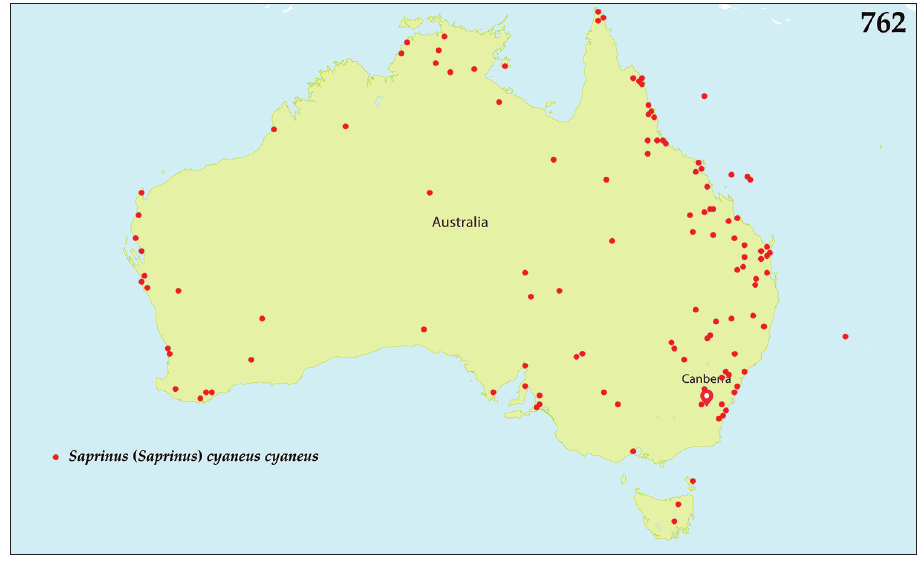
Figure 762. Distribution of Saprinus ( Saprinus ) cyaneus cyaneus (Fabricius, 1775) in Australia.